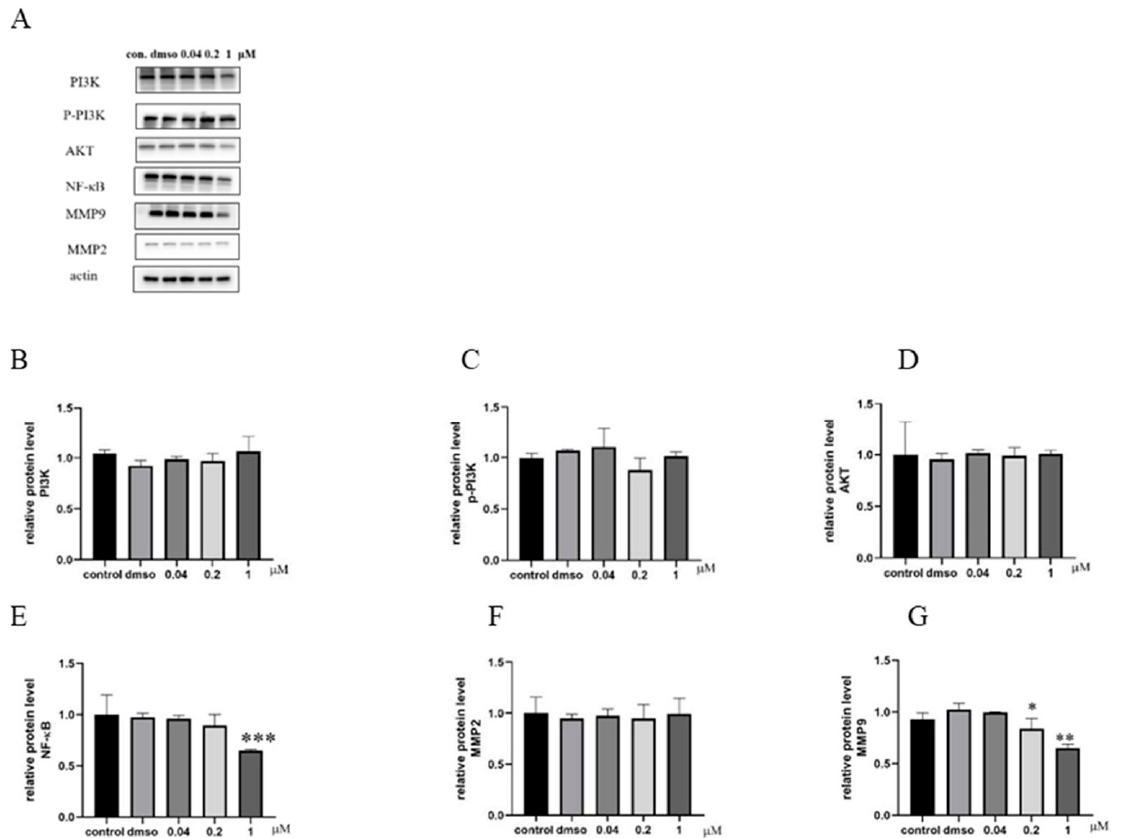
Figure 5. ( A ) The representative Western blot of PI3K, P-PI3K, AKT, NF- κ B, MMP-2 and MMP-9 in A375 cells treated with indicated concentrations of CHJ04022R for 48 h. ( B – G ) The quantitative analysis of these proteins in A375 cells affected by CHJ04022R . Three independent experiments were performed. All data were expressed as the mean ± SEM. * p < 0.05, ** p < 0.01, *** p < 0.001 compared to the control group.